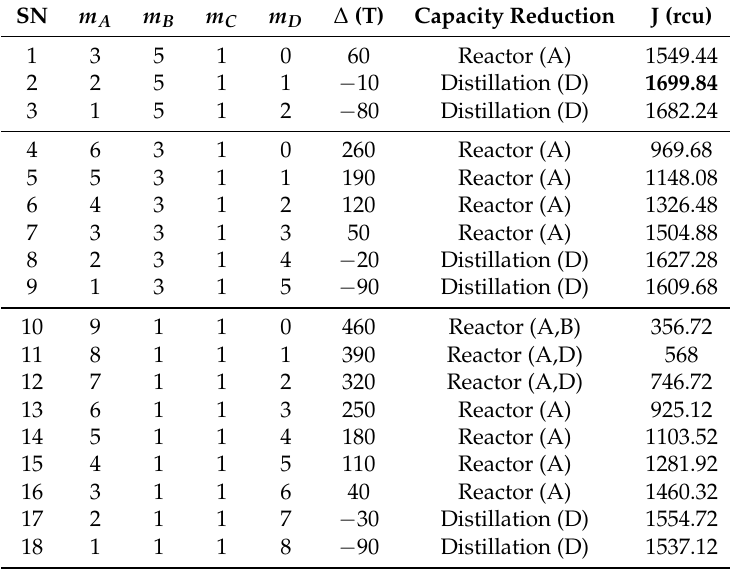
Table 4. Candidate solutions for BR-S system for scheduling horizon of 24 h (optimal solution highlighted in